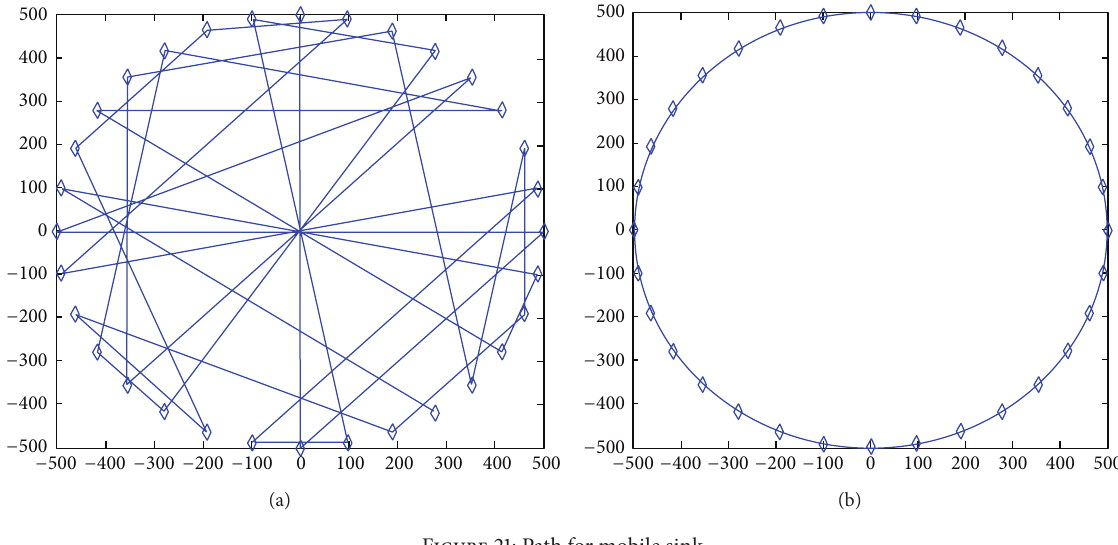
Figure 21: Path for mobile